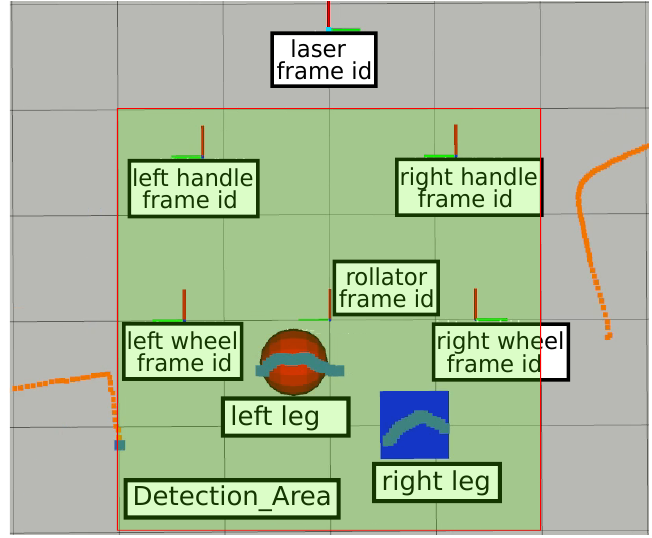
Figure 7. Live data capture screenshot. Legs are detected within the detection area and labeled using filtered laser